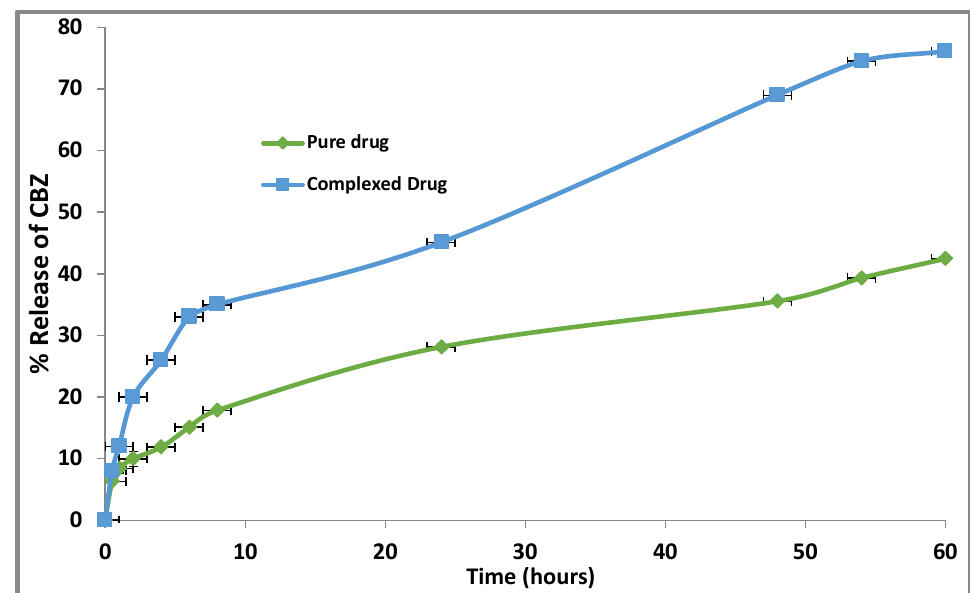
Figure 5. Comparative release profile of the pure drug (FA) and the complexed drug (CBZ-FA) in simulated gastric fluid, pH 1.2 at 37 ± 2 °C.